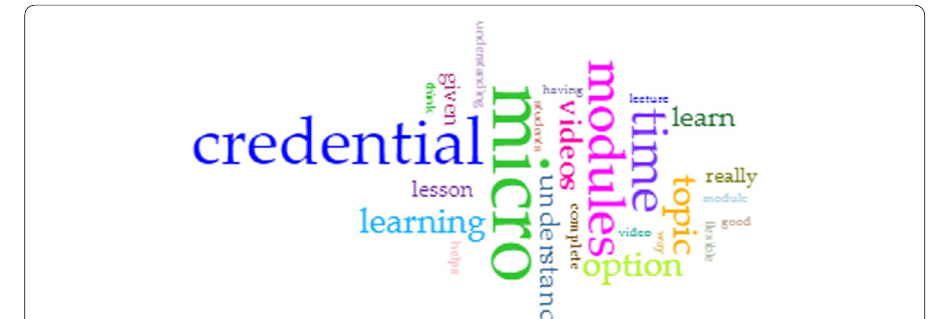
Fig. 4 Word cloud for perceived benefits